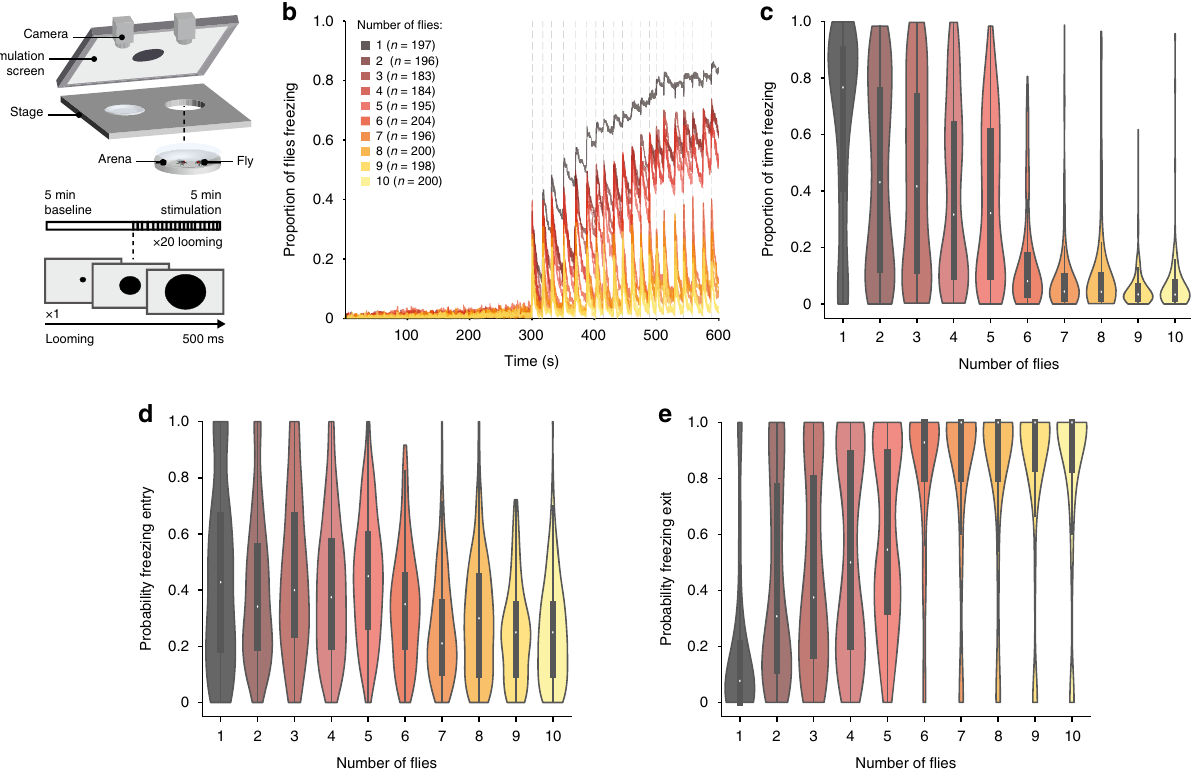
Fig. 1 Analysis of the group effect on freezing responses. a Experimental setup and protocol. We tested individuals and groups of up to 10 fl ies in backlit arenas imaged from above. After a 5-min baseline fl ies were exposed to twenty 500 ms looming presentations, every 10 – 20 s, indicated by vertical dashed lines. b Proportion of fl ies freezing throughout the experiment. c – e Violin plots representing the probability density of individual fl y data bound to the range of possible values, with boxplots (elements: center line, median; box limits, upper (75) and lower (25) quartiles; and whiskers, 1.5× interquartile range). c Proportion of time spent freezing throughout the experiment. Statistical comparisons between conditions presented in Supplementary Table 1. d Probability of freezing entry after looming presentation. Statistical comparisons between conditions presented in Supplementary Table 2. e Probability of freezing exit before the following looming stimulus. Statistical comparisons between conditions are presented in Supplementary Table